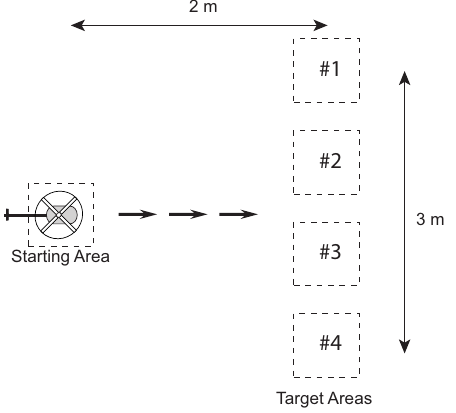
Figure 13. Experimental step task used to investigate the low-level control and guidance